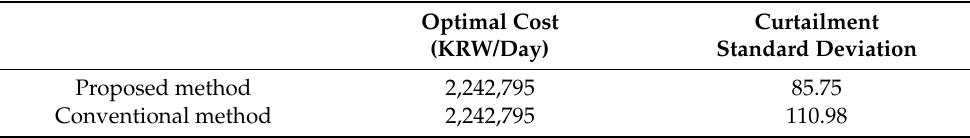
Table 4. Comparison of proposed and conventional method